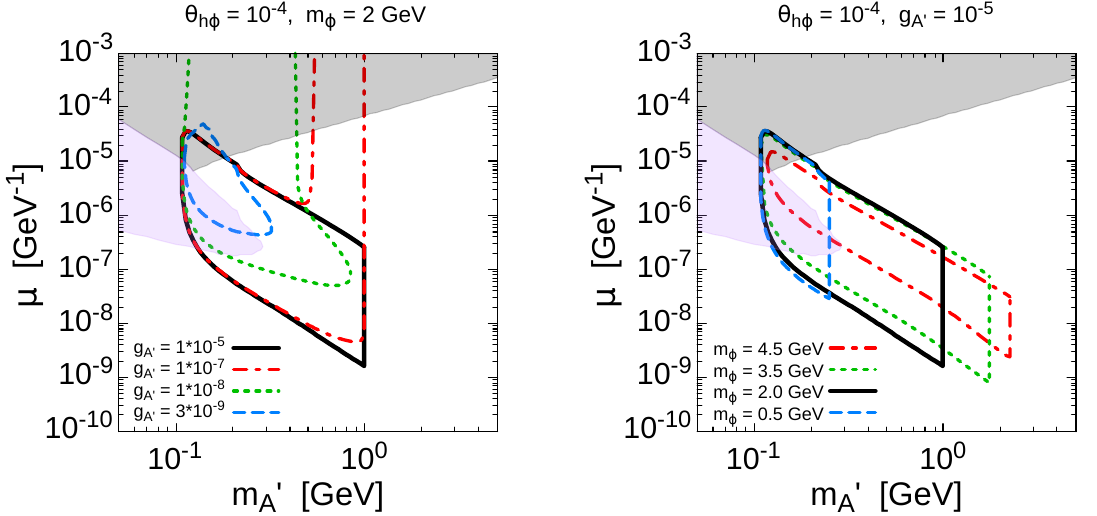
Figure 5 . The contour plots of 95 % C.L. sensitivity regions for the dipole interaction. The gray and the purple shaded area are excluded by µ → eee and E137,